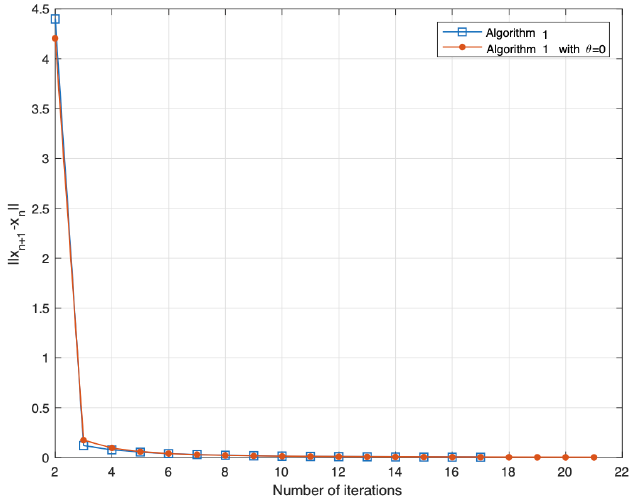
Figure 1. Comparing Algorithm 1 with Algorithm 1 defined without the inertial